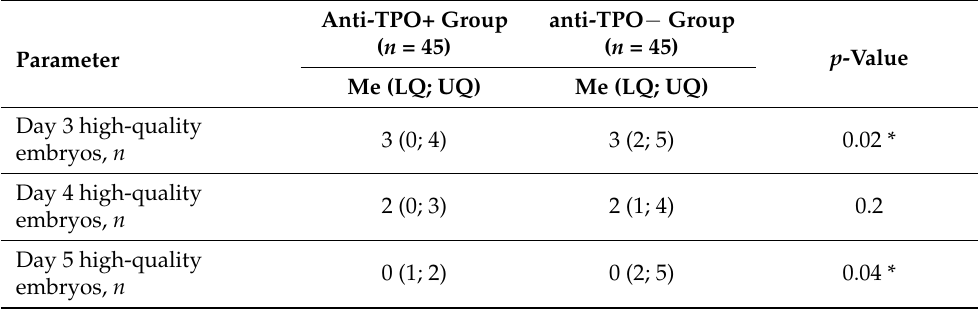
Table 5. Comparative analysis of embryological outcome in groups